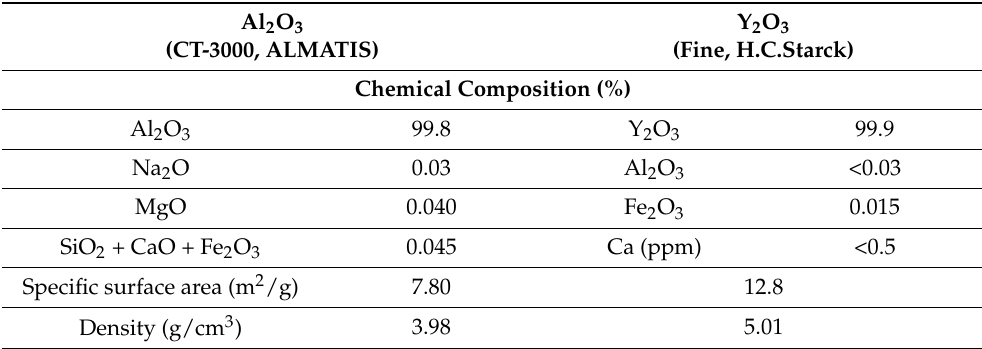
Table 1. Characteristics of the starting Al 2 O 3 and Y 2 O 3